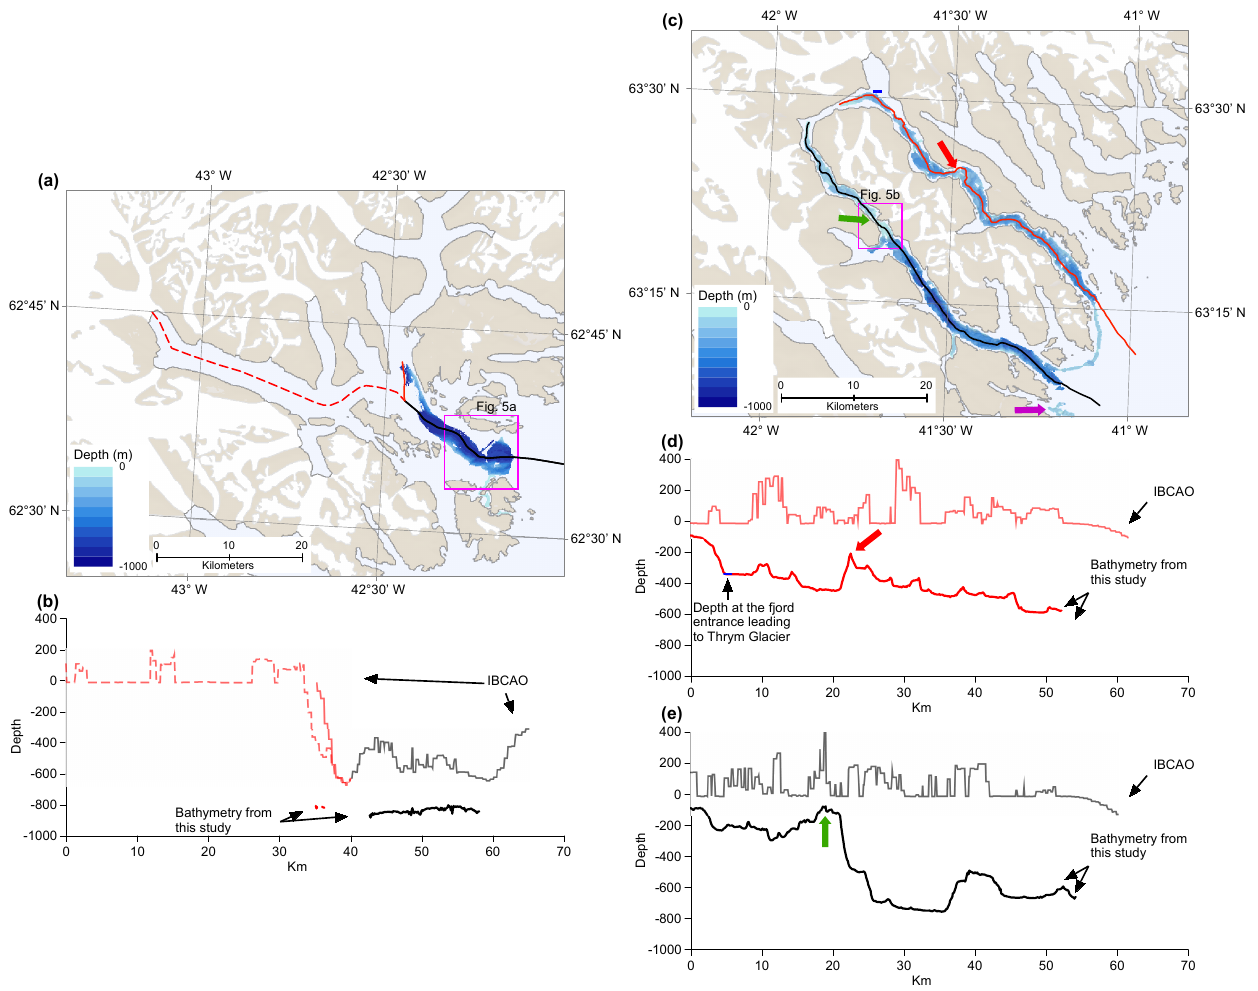
Figure 4. Surveyed bathymetry in the Timmiarmiut Fjord system (a) . The three colored lines follow the deepest part along the fjords and are illustrated in panel (b) , representing the outer well-surveyed area (black line), the branch towards the north leading to Heimdal Glacier at the head, and towards Timmiarmiut Glacier (dashed red line). The surveyed bathymetry around Skjoldungen is illustrated in panel (c) , while panel (d) shows the longitudinal profiles of Søndre Skjoldungesund (black lines) and Nørre Skjoldungesund (red lines). Green, red, and magenta arrows in panels (c) and (d) indicate the prominent sill in SSsund, the local high in NSsund, and the offshore shoal, respectively. For the profiles in panels (b) and (d) , bathymetry obtained from IBCAO is